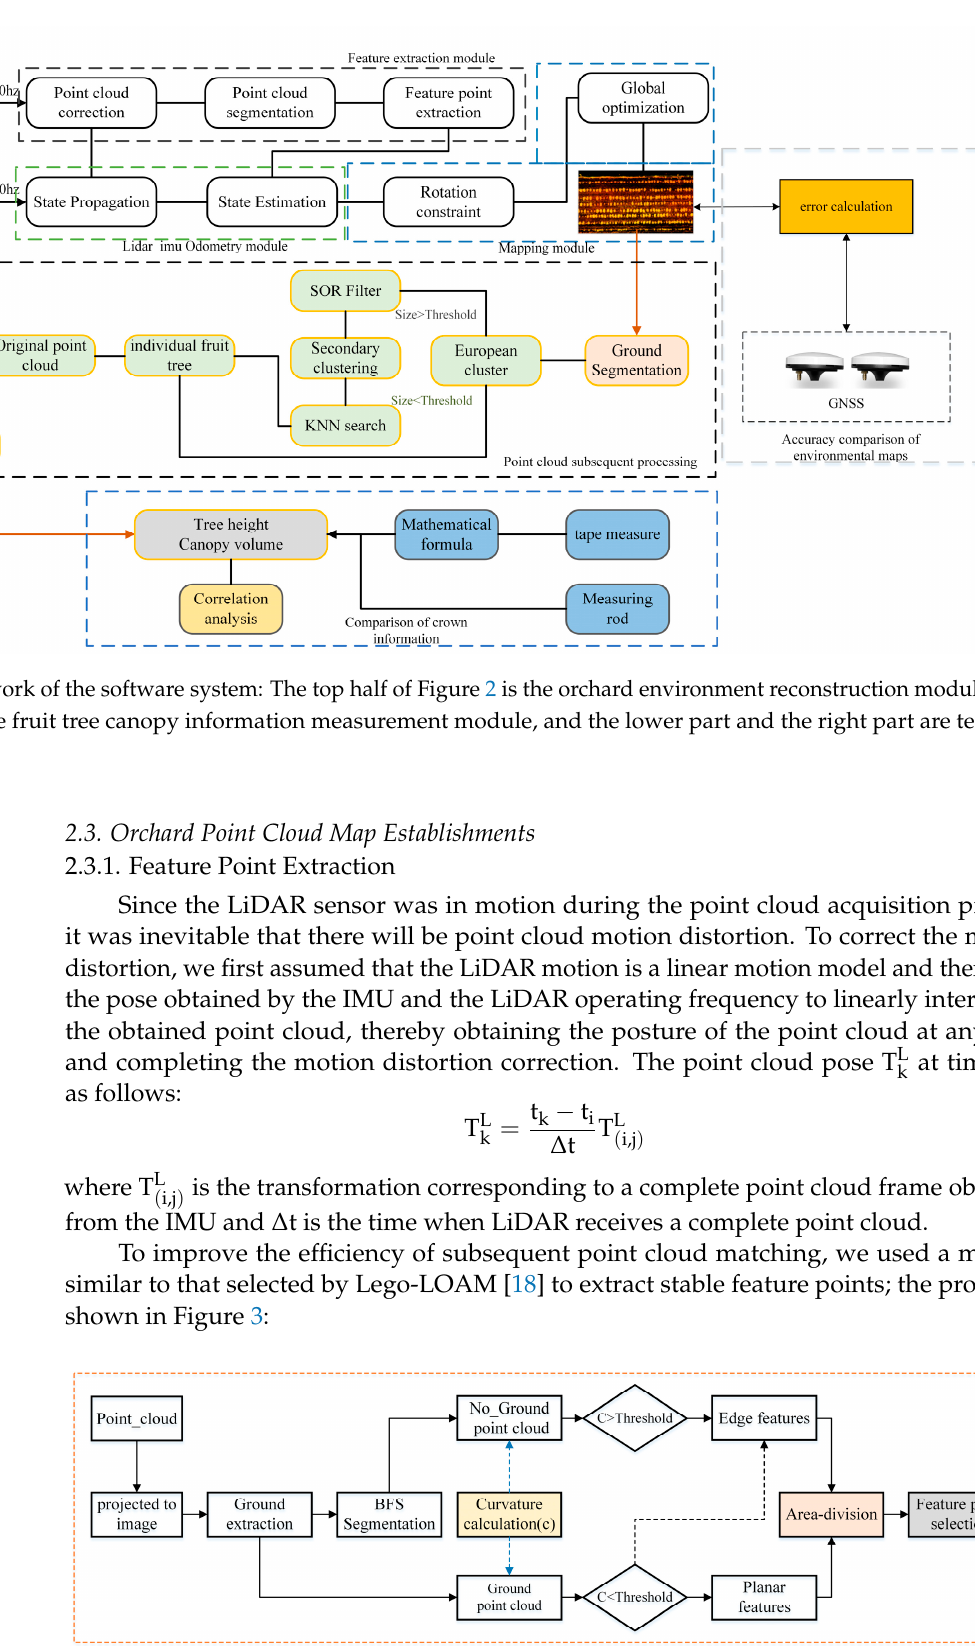
Figure 3. Feature point extraction process. First, point cloud acquired by LiDAR was projected into a range image (the image resolution was 16 × 1800) and the distance r from the pixel value in the image to the